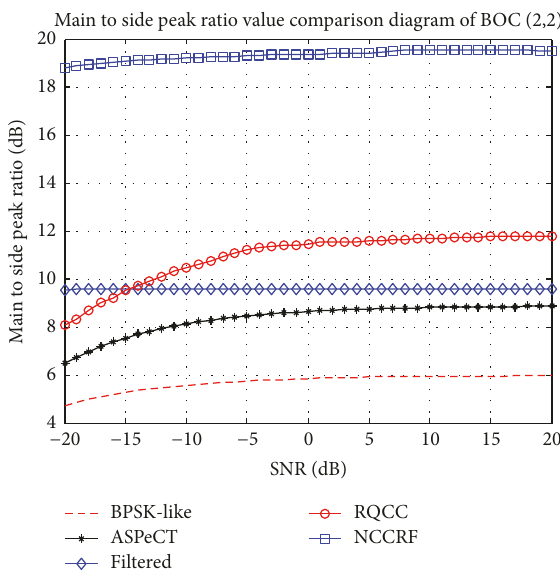
Figure 8: The MSPR comparison of BOC ( 2,2